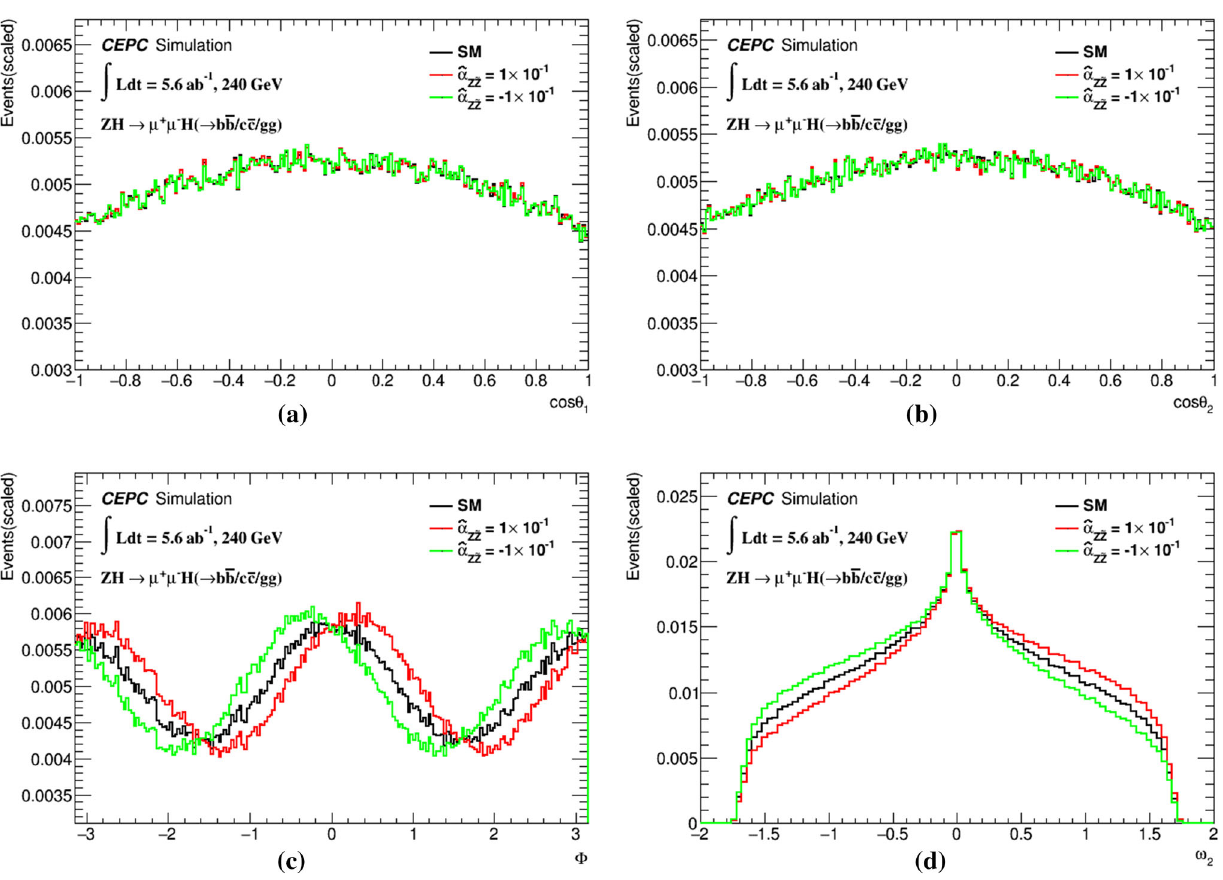
Fig. 2 Parametric curves with different ˆ α values. The optimal variable ω 2 is defined in the text. (The value of ω 2 here is multiplied by 1000 for Z ˜ Z numerical convenience.)